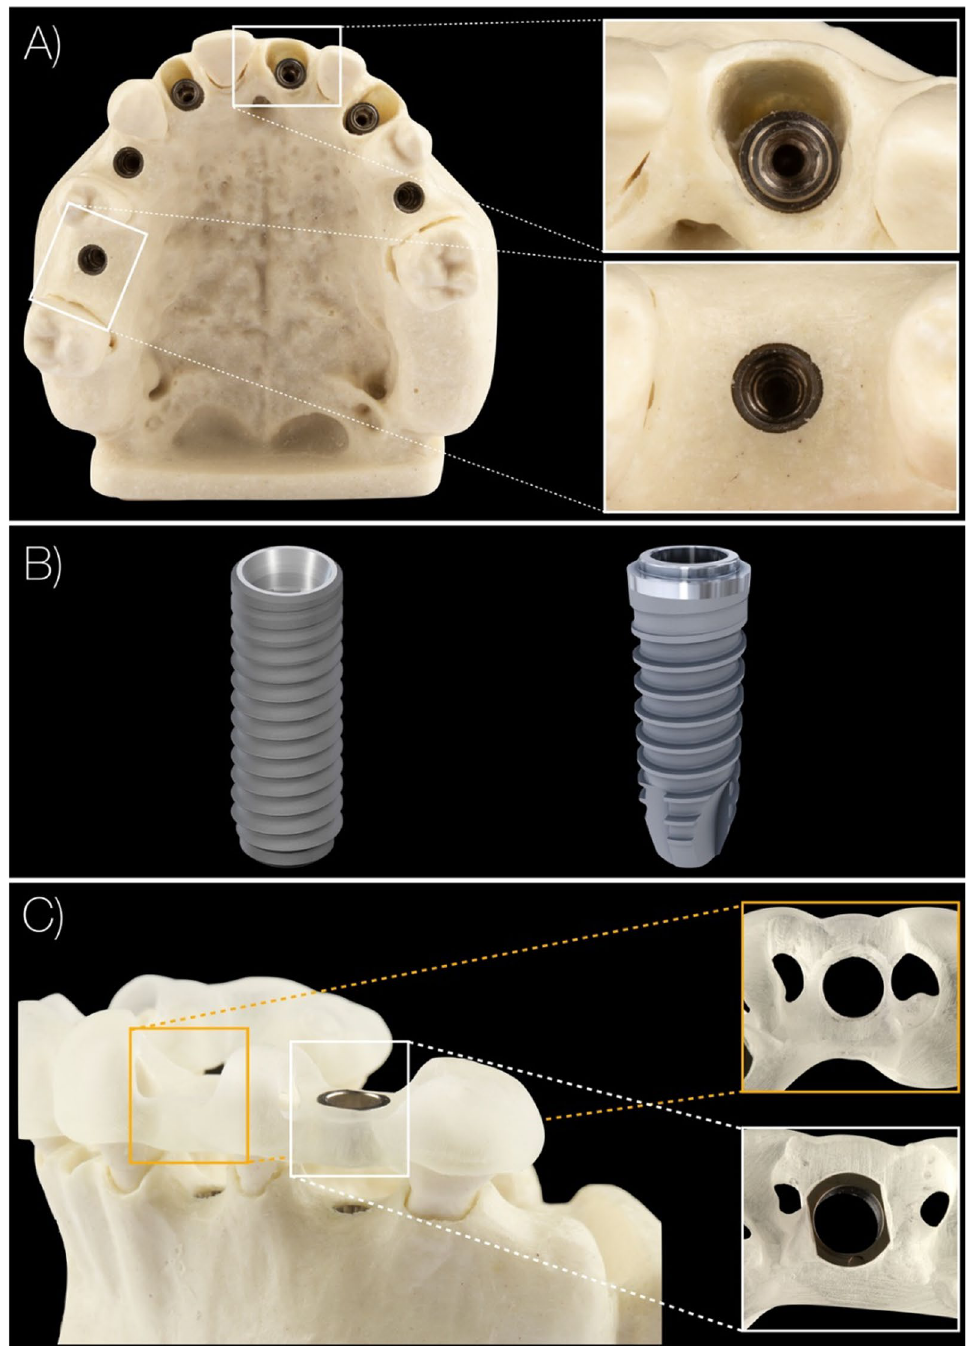
Fig. 1 Representative case of a model with implants placed in fresh extraction sockets and healed ridges. Different alveolar ridge morphologies ( A ); implants of the drill‑key (left) and keyless (right) systems ( B ). Sleeveless sites (orange); standard manufacturer’s sleeve (white) ( C